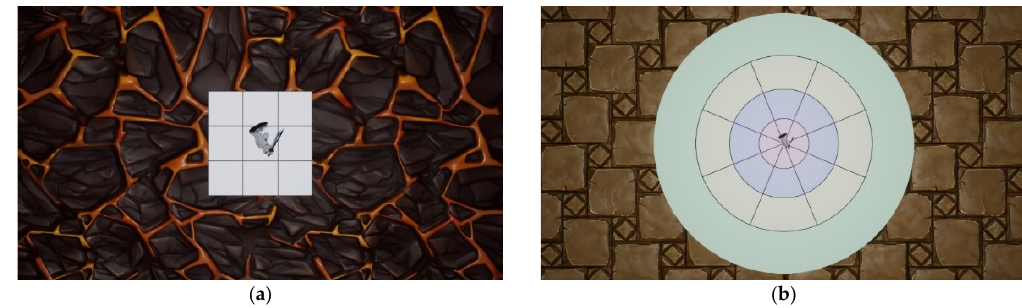
Figure 3. Test levels. ( a ) BAI; ( b ) IBAI.